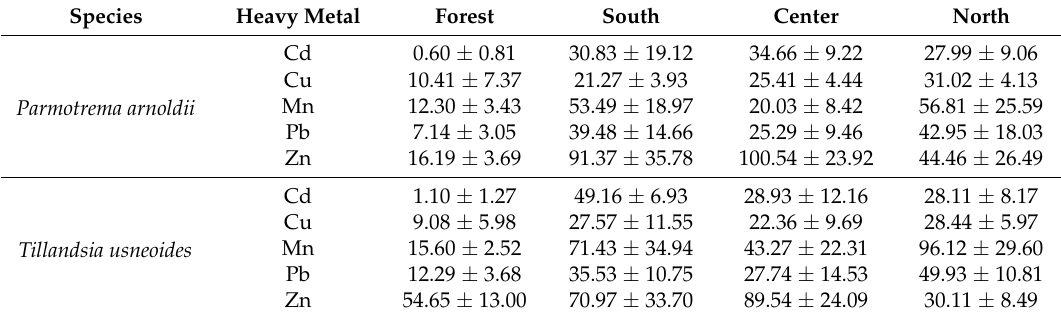
Table A1. Mean concentration and standard error of Cd, Cu, Mn, Pb and Zn in Parmotrema arnoldii (PA) and Tillandsia usneoides (TU) from the Loja city